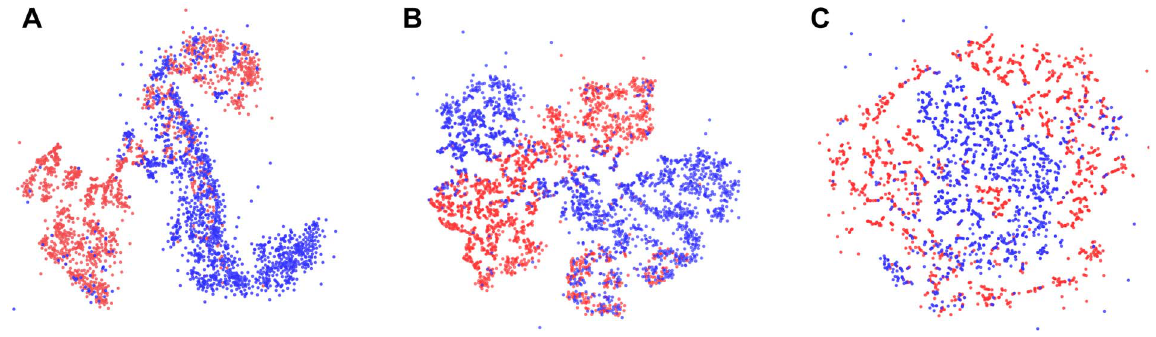
Figure 5. Data distribution in the learned feature spaces suggests disease subpopulations. A: First-layer features. B: Second-layer features. C: Expert engineered features. These two-dimensional embeddings using t-SNE suggest several subpopulations of gout (red) and leukemia (blue) in both learned feature spaces. We suspect that these subpopulations largely represent differences in treatment approach, but they may also be illuminating pathophysiologic differences. The engineered feature space separates the two known phenotypes adequately for a discrimination task, but offers only weak suggestions of subpopulations: without the colors corresponding to known phenotypes, it would be difficult to identify more than a single large cluster in this space. The t-SNE algorithm preserves near neighbor distances at the expense of far neighbor distances, so we cannot draw conclusions from the macro-scale shape or relative orientation of the clusters, only their number and substructure.